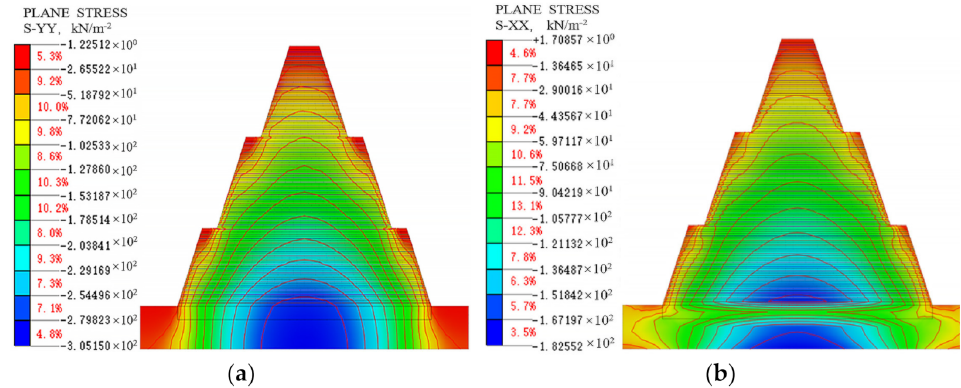
Figure 13. Vertical and horizontal pressure cloud images: ( a ) vertical earth pressure cloud diagram; ( b ) horizontal earth pressure cloud diagram.